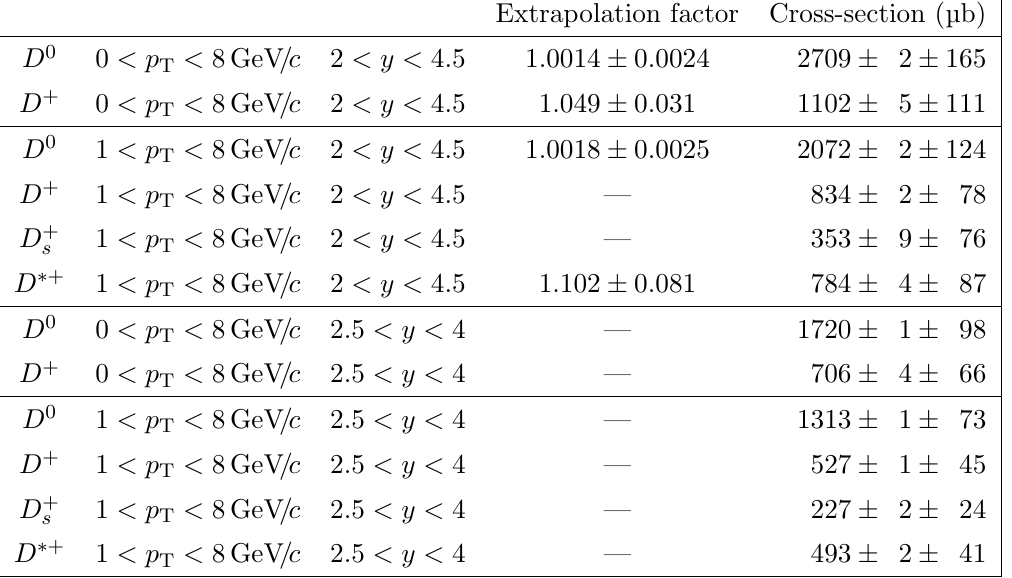
Table 3. Prompt charm production cross-sections in the kinematic ranges given. The computation of the extrapolation factors is described in the text. The (cid:12)rst uncertainty on the cross-section is statistical, and the second is systematic and includes the contribution from the extrapolation factor. No extrapolation factor is given for D + ( s ) as a measurement is available in every bin of the integrated phase